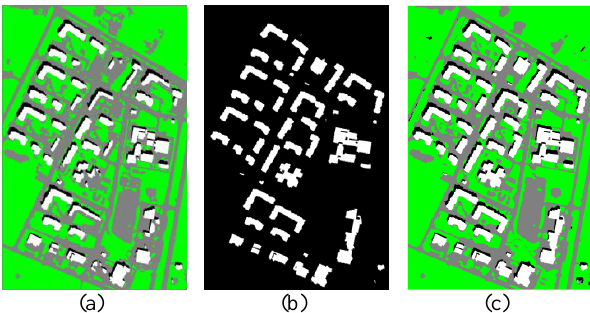
Figure 3. (a) The input of Stage II, (b) verified building regions, and (c) the output of Stage II. White, green, black, and grey colours indicate the regions for the classes building, vegetation, shadow and others,